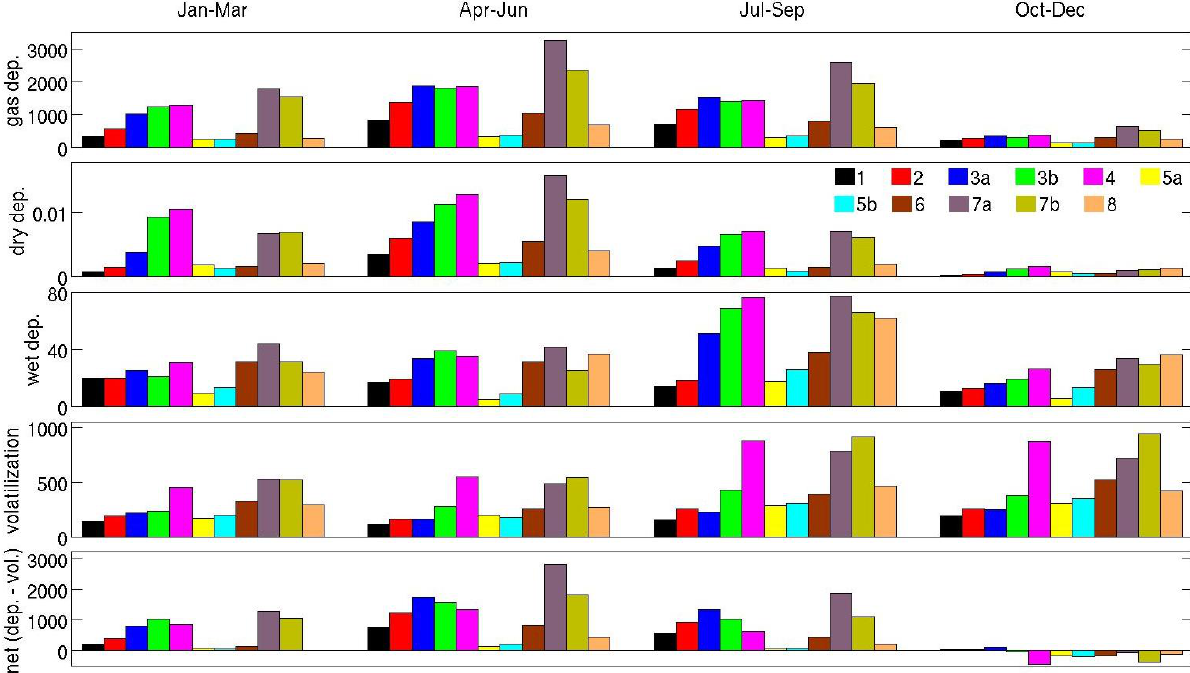
Figure 6. Bar charts of integrated quarterly (3 month) fluxes (kg) by ICES boxes (Figure 1) of γ-HCH in 2000: gas deposition ( top row ), dry deposition ( 2nd row ), wet deposition ( 3rd row ), volatilization ( 4th row ), and net air-sea exchange ( bottom row